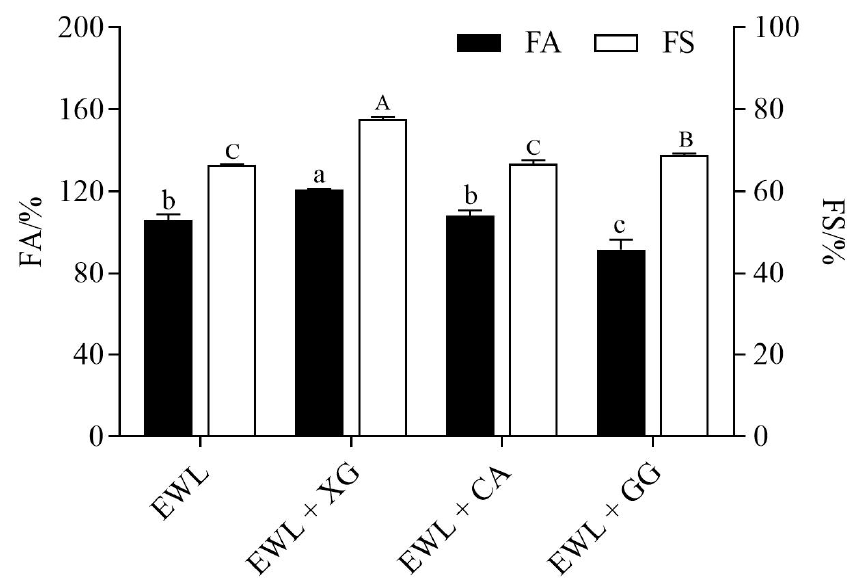
Figure 1. Effects of polysaccharide added to egg white liquid on FA and FS. Different lowercase letters indicated significant differences ( p < 0.05) between FA groups, and different uppercase letters indicated significant differences ( p < 0.05) between FS groups.